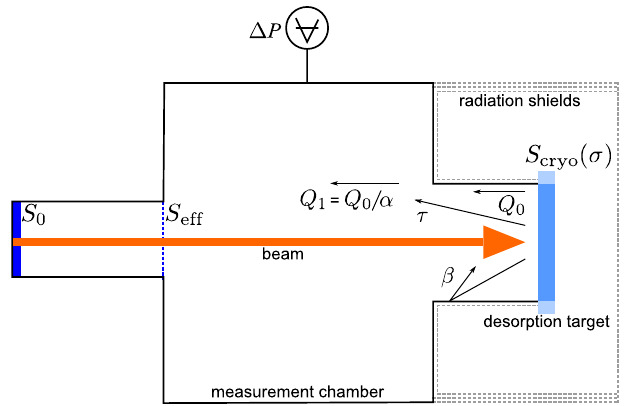
FIG. 3. Schematic display of the gas flux, pumping speeds, and geometry relevant for the heavy-ion-induced desorption of a cryogenic target installed in the experimental vacuum